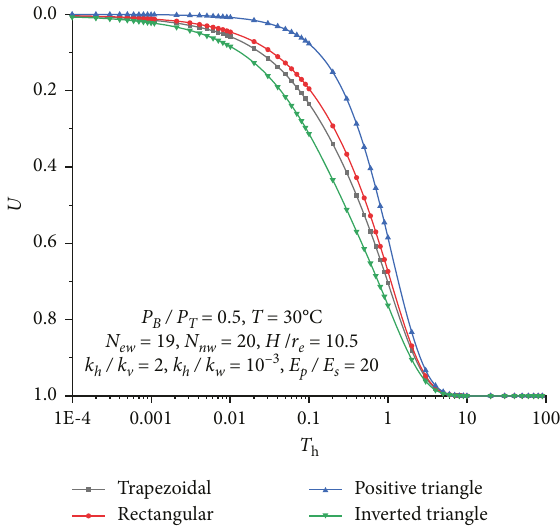
Figure 6: Influence of pile-soil compression modulus ratio on foundation consolidation